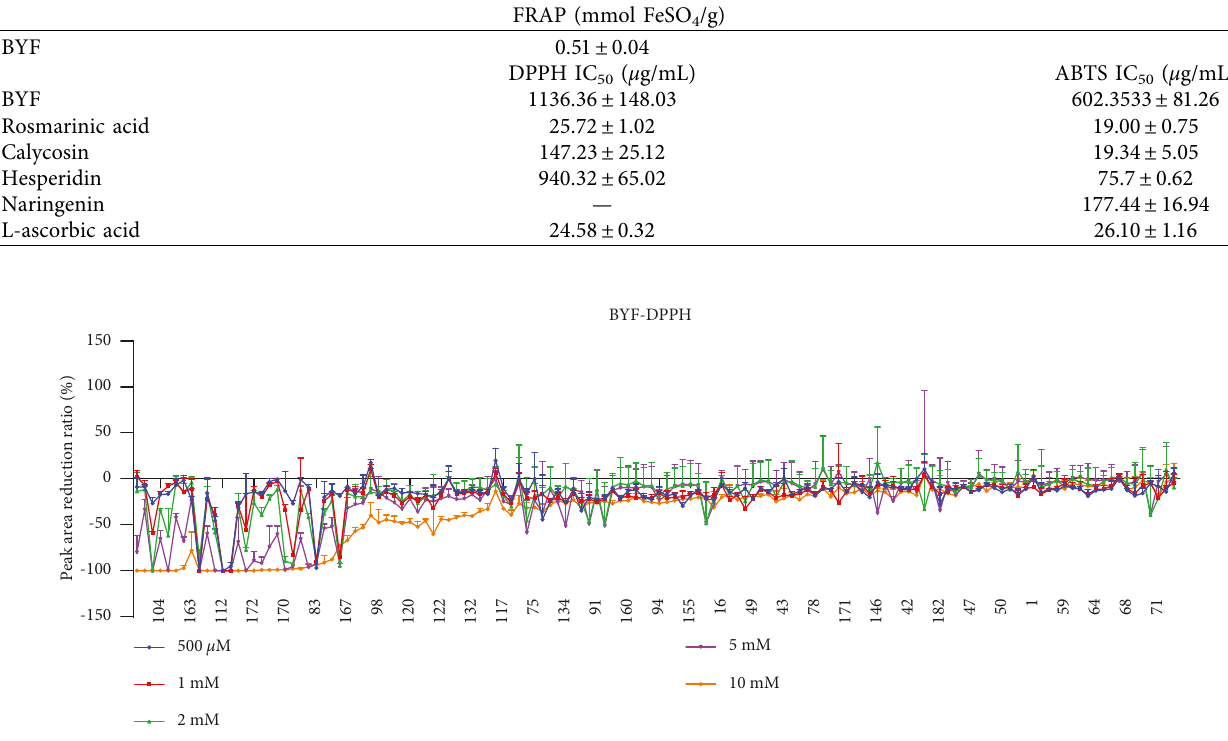
Figure 4: MS Intensity reduction for compounds in BYF after reaction with DPPH at different concentrations (500 μ M, 1mM, 2mM, 5mM, and 10mM). The compound numbers marked on the X -axis refer to Table 1.